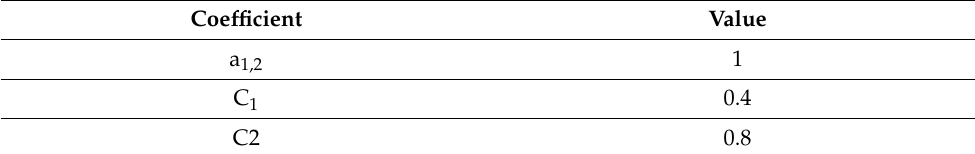
Table 1. The systematically designed delta–sigma modulator coefficients.